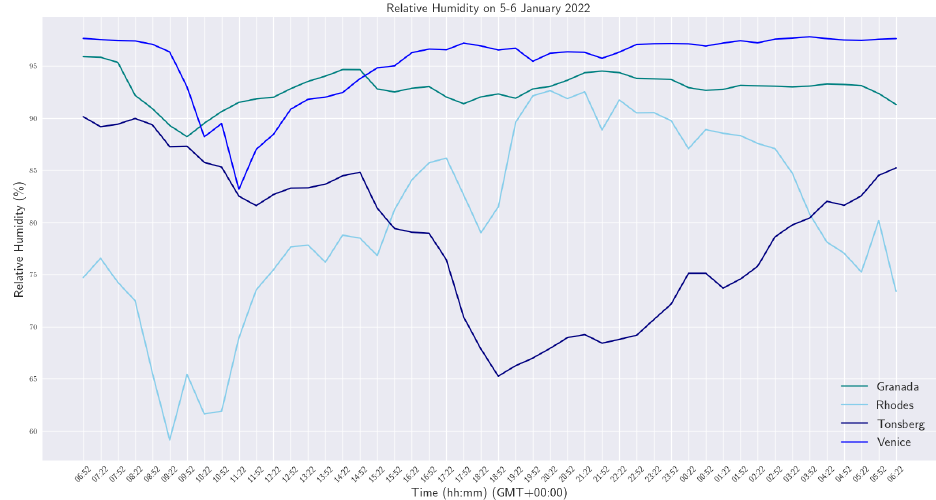
Figure 12. Relative Humidity graph on the four CH sites at 5 and 6 January 2022.